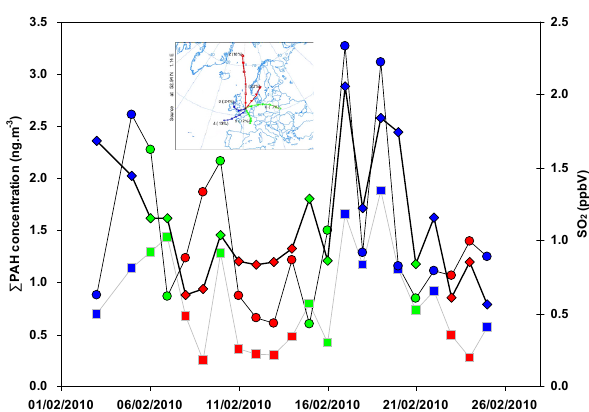
Fig. 1. Temporal trend of SO 2 (secondary axis, diamonds), ∑ PAH particulate phase (squares) and vapour phase (circles) for the winter sampling period 2 February 2010 to 25 February 2010. Colours signify three grouped air masses determined by cluster analysis, see embedded image and/or Fig S1a for colour codes